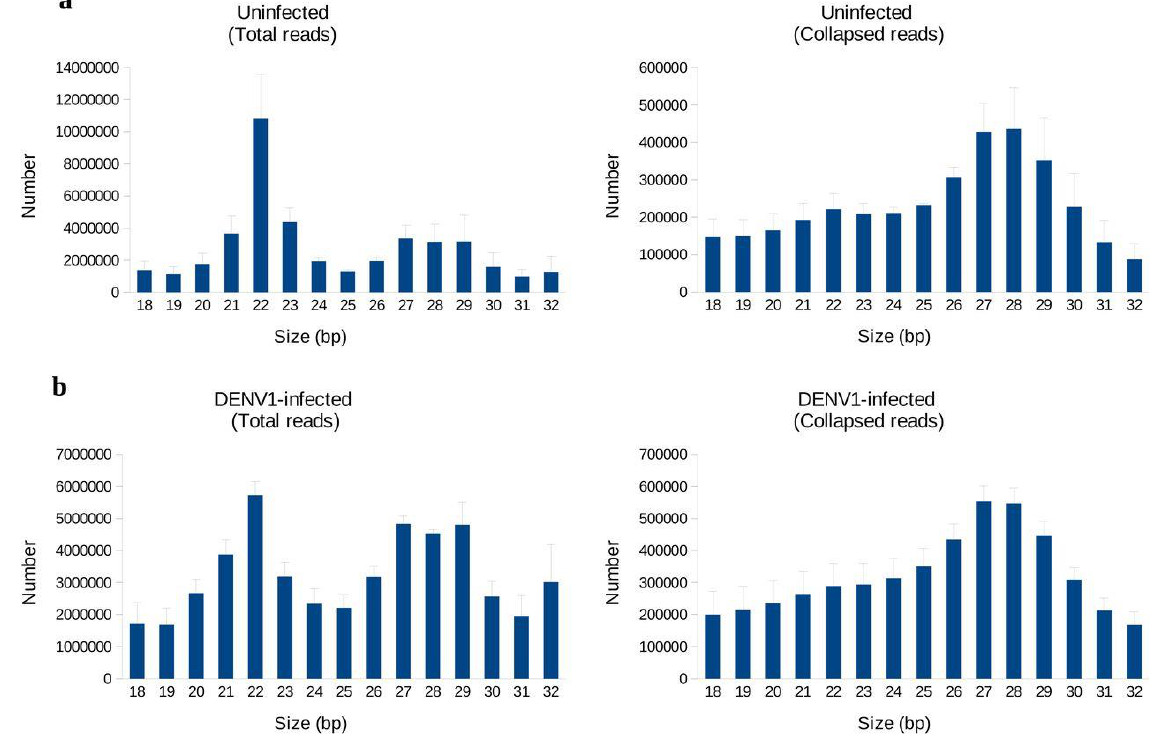
Figure 1. Length distribution of small RNAs in DENV1-infected and uninfected C6/36 cells. Size distribution of small RNA reads in uninfected samples ( a ) and DENV1-infected samples ( b ).